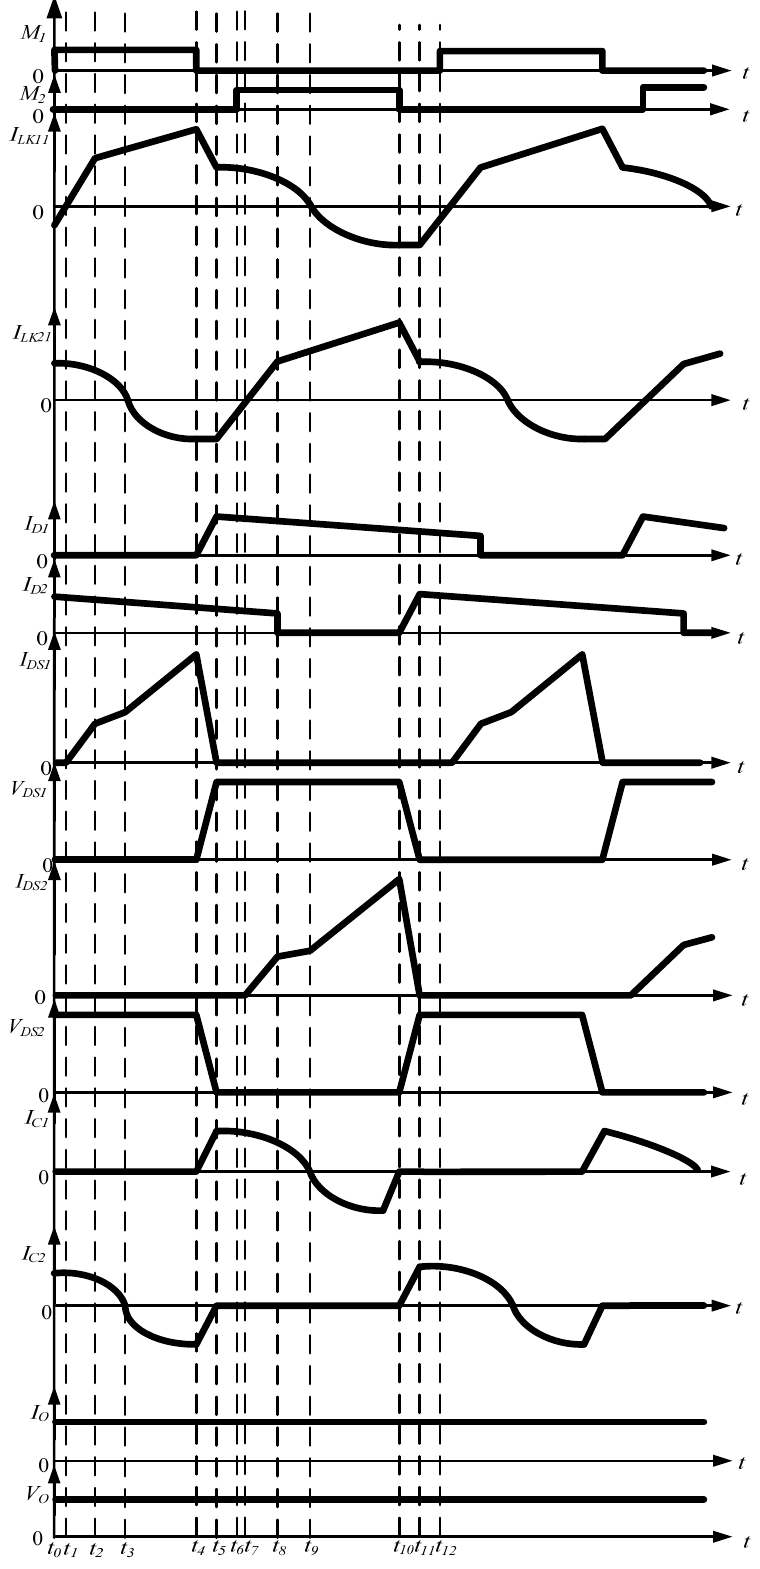
Mode 1 (Figure 11a: t are forwardly biased, therefore, voltage V